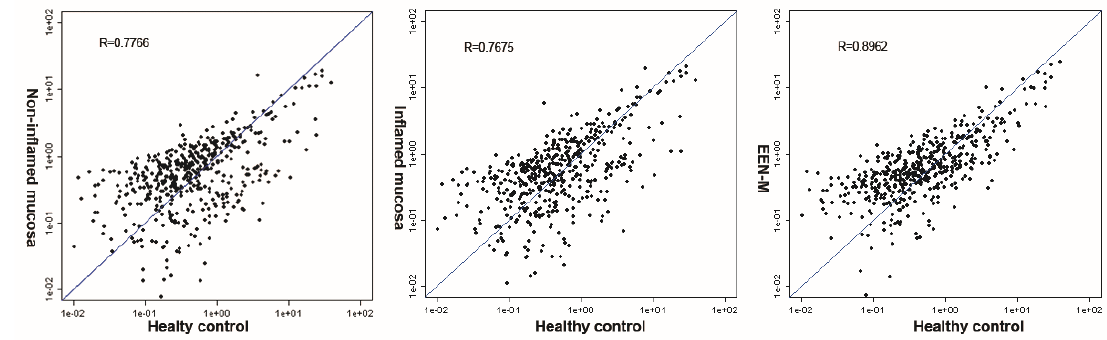
Figure 4. Correlation coefficient R-value and the scatter plot. The correlation coefficient R means the difference of miRNA samples. Bigger R values mean less difference.